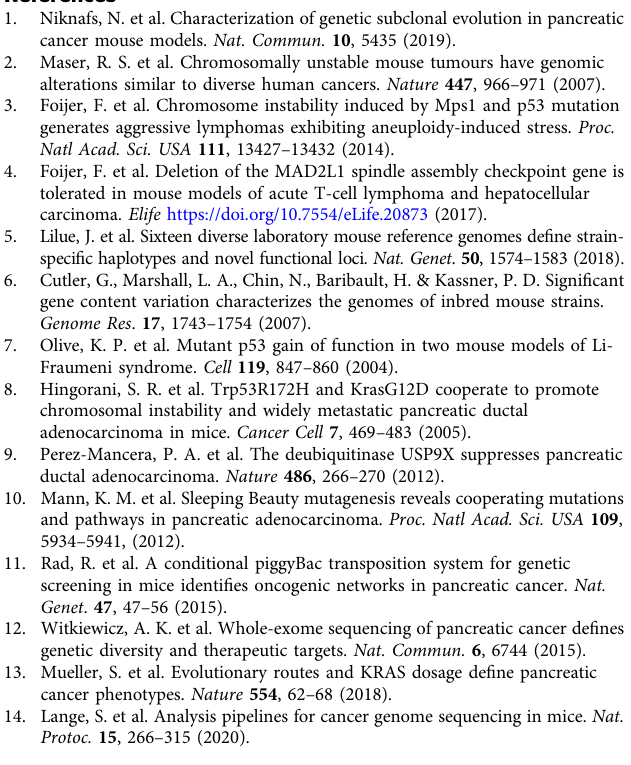
Fig. 2 Genetic linkage of strain-speci fi c variants to cancer genes undergoing LOH confound cancer genome analyses. a , b Trp53 ; Nlrp1 haplotype reconstruction by WES-based SNP analysis in germline and tumors of KPC mice ( a : KPC-5, b : KPC-6). Genomic regions with heterozygous SNPs contain two distinct alleles: one C57BL/6J- and one 129S-speci fi c haplotype (SNP frequencies: ~0.5; light blue background in SNP-plots). Conversely, regions with SNP frequencies of ~1.0 are pure 129S. Regions without values perfectly match the C57BL/6J reference genome (homozygous C57BL/6J). a In the germline, heterozygous SNPs con fi rm presence of two haplotypes: (1) Trp53 ENG-129S ; Nlrp1 129S (engineered Trp53 R172H allele; strain-speci fi c Nlrp1 129S variant) and (2) Trp53 WT ; Nlrp1 C57BL/6J . In the tumor, the Trp53 WT ; Nlrp1 C57BL/6J haplotype is lost through CN-LOH (re fl ecting selective pressure to lose Trp53 WT ). Homozygosity of the Trp53 ENG-129S ; Nlrp1 129S haplotype in the tumor manifests as a Nlrp1 locus deletion when compared to germline (right; CNV plot based on WES with Nlrp1 locus zoom-in). b In the germline, the Trp53 ; Nlrp1 haplotype is S129-derived on both copies of chr11. The Nlrp1 129S variant is already homozygous in the germline. CNV analyses relying on tumor/germline comparisons thus fail to detect the Nlrp1 alteration in the tumor (right; CNV plot based on WES with Nlrp1 locus zoom- in). c Germline SNP analysis of mouse KPC-7 backcrossed to C57BL/6J for fourteen generations. High SNP densities persist in genomic proximity of engineered alleles. d Germline CNV pro fi les at the Skint locus in three inbred mouse strains as compared to C57BL/6J. Red dots, aCGH probes within Skint locus alteration (data from ref. 6 ). e Upper panel: Skint locus CNV pro fi le in primary pancreatic cancer cell culture (compare to germline Skint alterations in Fig. 2d). Lower panels: WES-based Cdkn2a ; Skint haplotype reconstruction as in Fig. 2a, b. In the germline, heterozygous SNPs con fi rm presence of two haplotypes: (1) Cdkn2a ; Skint C57BL/6J and (2) Cdkn2a ; Skint 129S . During tumor evolution, the Cdkn2a locus is fi rst somatically deleted ( Cdkn2a Δ ) on the chromosome carrying the Skint 129S variant ( Cdkn2a Δ ; Skint 129S ) followed by CN-LOH of the Cdkn2a Δ ; Skint 129S allele, re fl ecting selective pressure to lose Cdkn2a WT . Homozygosity of Skint 129S in the tumor manifests as a Skint locus deletion when compared to germline (right; CNV plot based on WES with Skint